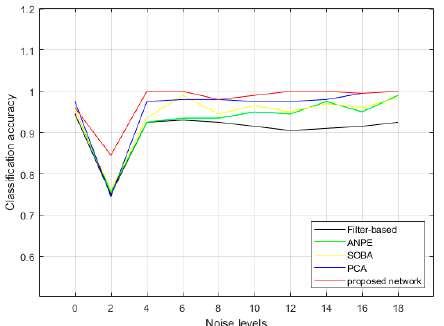
Figure 12. The accuracy curves of the classification of noisy image patches into different noise levels with different estimation methods.